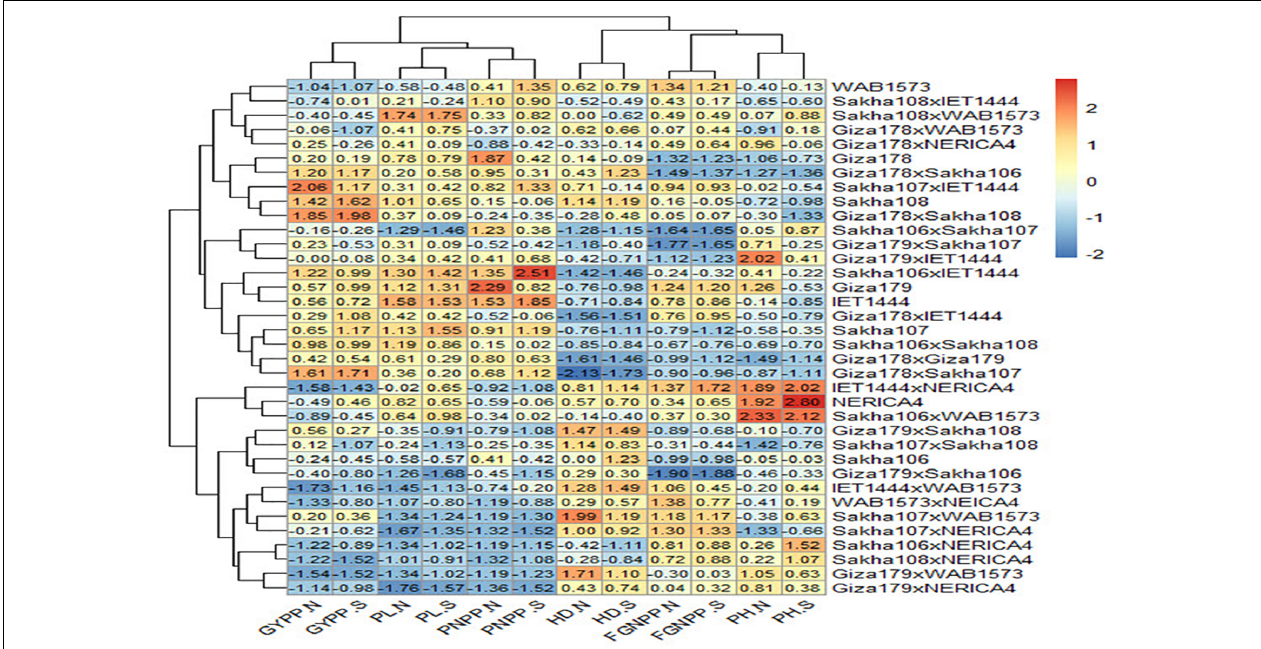
FIGURE 4 | A heatmap of the relationship between genotypes and the traits studied under normal (.N) and water stress (.S) conditions. GYPP, grain yield per plant; PL, panicle length; PNPP, panicle number per plant; HD, number of days to 50% heading; FGNPP, number of filled grains per panicle; PH, plant height.